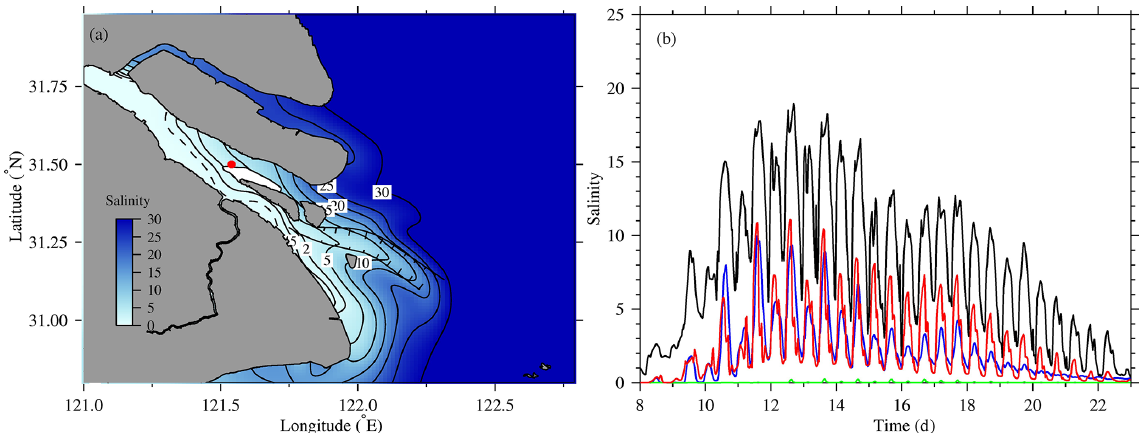
Figure 12. Distribution of time-averaged surface salinity from 10 to 13 February 2014 (a) . Temporal variations in salinity from 8 to 22 Febru- ary 2014 at hydrologic stations (b) if the upper reaches of the northern branch are blocked and under realistic wind and residual water levels at the open sea boundaries. Black line – Baozhen; red line – Nanmen; green line – Chongxi; blue line – Qingcaosha. (cid:0) (cid:1) ∂ 1 K m ∂v are vertical turbulence viscosity, and F ξ and ∂σ ∂σ D 2 F η are horizontal turbulence viscosity in the ξ and η di- rections, respectively. Each output term in the momentum equations was vertically averaged, and the vertical turbulence − τ bξ (cid:0) (cid:1) (cid:0) (cid:1) ∂ ∂ K m ∂u K m ∂v viscosity 1 and 1 equals τ aξ , ∂σ ∂σ ∂σ ∂σ D D 2 D 2 τ aη − τ bη , in which τ aξ , τ aη and τ bξ , τ bη are the wind D